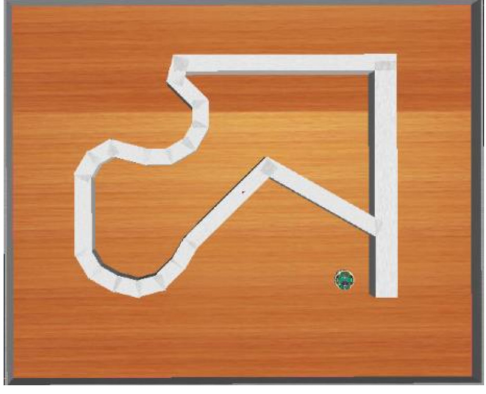
Figure 9. Training